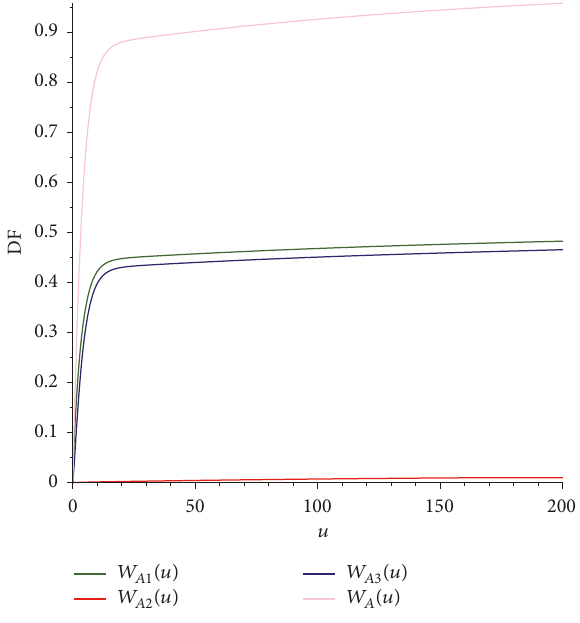
Figure 2: 𝑢 versus distribution function.